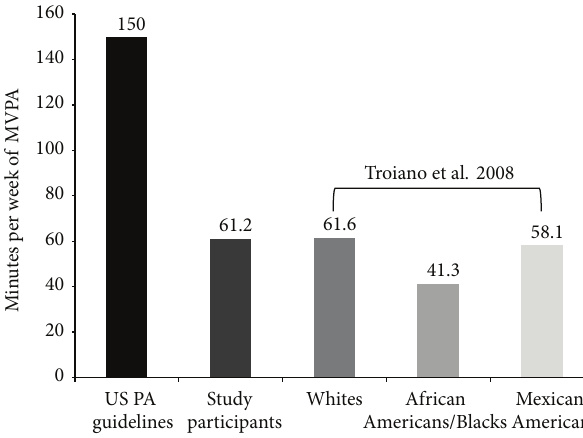
Figure 1: Level of moderate to vigorous physical activity (MVPA) recommended by the current United States physical activity guide- lines, mean level of MVPA observed in the older African American women participating in this study ( 𝑛 = 7 ) living in Urbana- Campaign, IL, and mean level of MVPA observed in the national sample of older women (60 and plus) reported in the Troiano et al. study